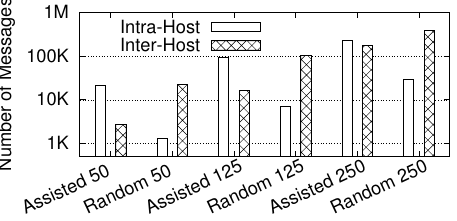
Figure 12: Assisted vs. Random resource